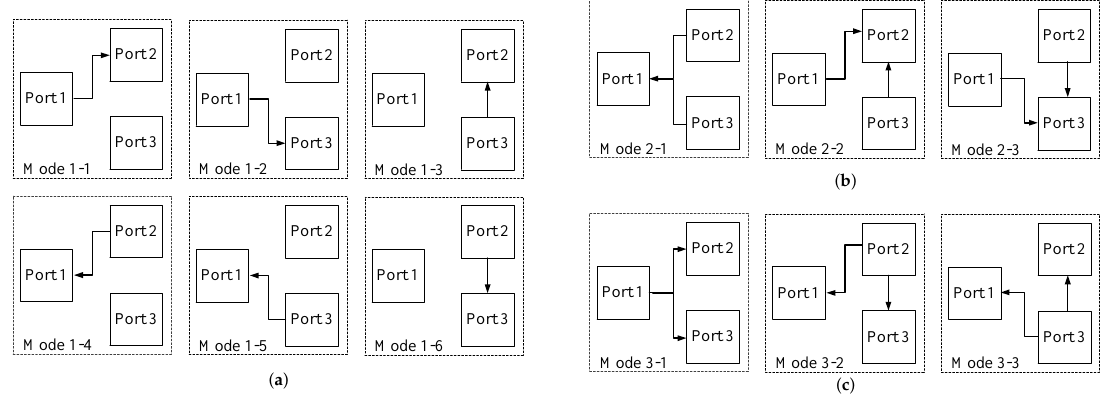
Figure 7. Operation modes of TAB converter: ( a ) Single input single output (SISO), ( b ) Dual input single output (DISO), ( c ) Single input dual output